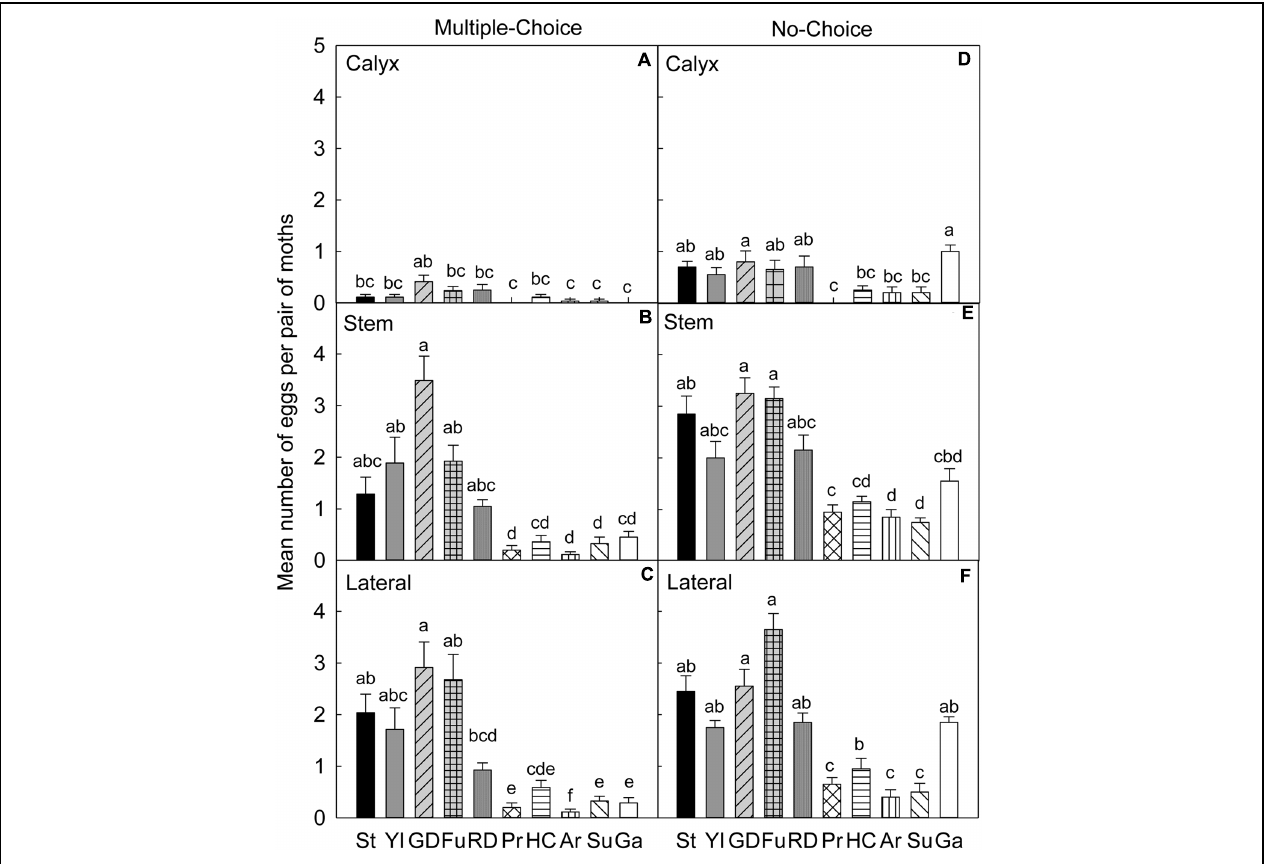
FIGURE 3 | Relative susceptibility of different apple cultivars for oviposition of codling moth during July 2007 (early season/Set 1). Mean number of eggs per pair of moths per fruit on calyx, stem, and lateral sides of fruits of different cultivars are shown in multiple-choice tests (A–C) and no-choice tests (D–F) . St, Stayman; YI, York Imperial; GD, Golden Delicious; Fu, Fuji; RD, Delicious; Pr, Pristine; HC, Honeycrisp; Ar, Arlet; Su, Sunrise; Ga, Gala. N = 8 for all the multiple-choice tests, and N = 10 for all the no-choice tests. Each bar represents standard error of mean. Different letters over bars indicate significant difference ( P <